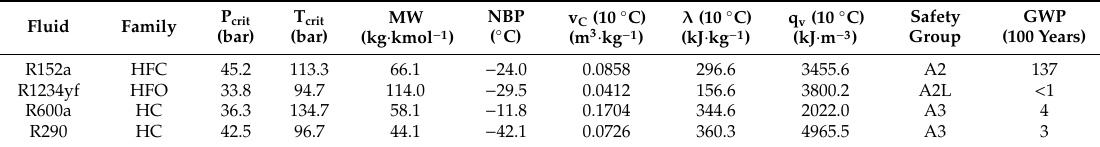
Table 8. Thermodynamic properties, safety classification and GWP values for the analyzed